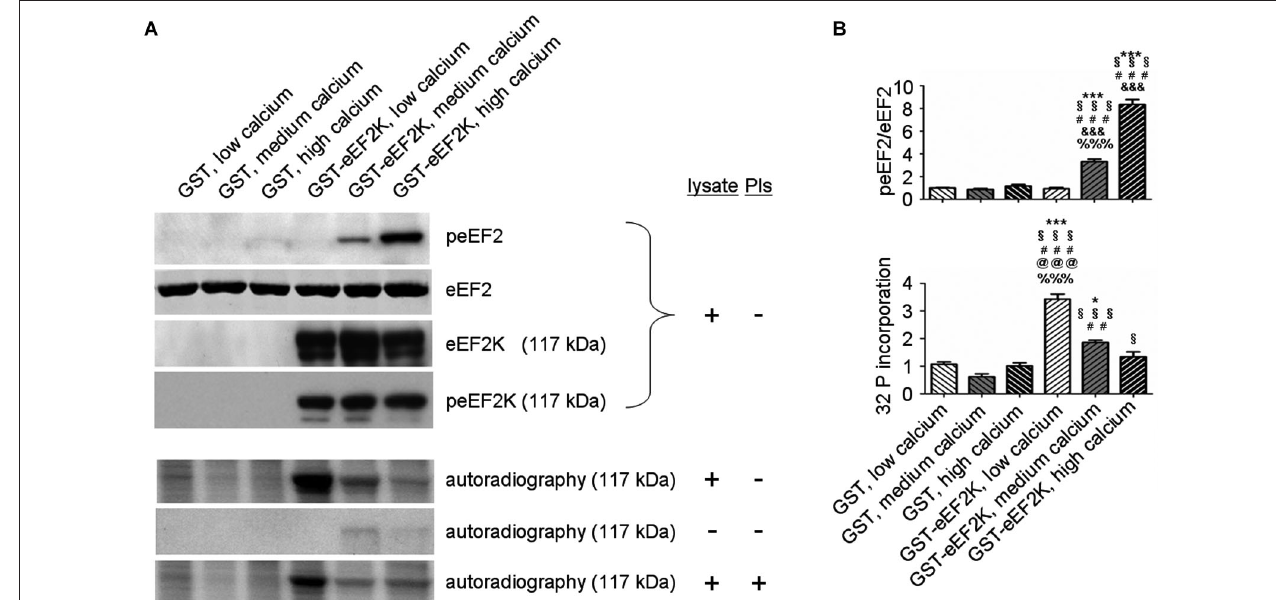
FIGURE 2 | eEF2K activity and total eEF2K phosphorylation are negatively correlated in vitro . (A) Phosphorylation assays with varying levels of freely available calcium and subsequent western blot and autoradiographical analysis reveal a negative correlation between eEF2K activity and total eEF2K phosphorylation. Assays were carried in a total volume of 60 µ l for 30 min at 37 ◦ C and had the following final